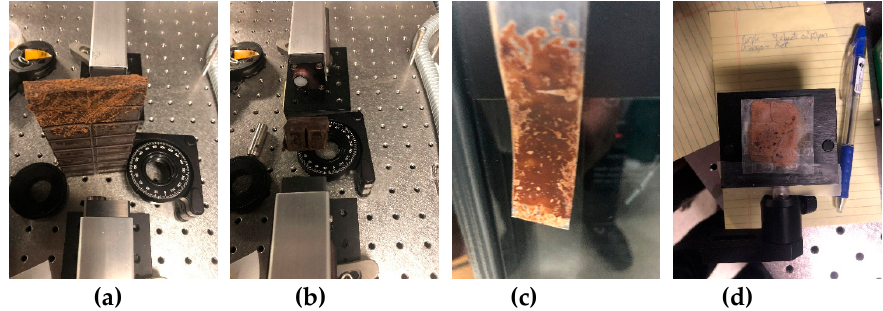
Figure 21 . Samples with chocolate bar (a,b) and powdered chocolate in the polyethylene bag (c,d) in Figure 21. Samples with chocolate bar ( a , b ) and powdered chocolate in the polyethylene bag ( c , d ) in the THz setup. the THz setup.